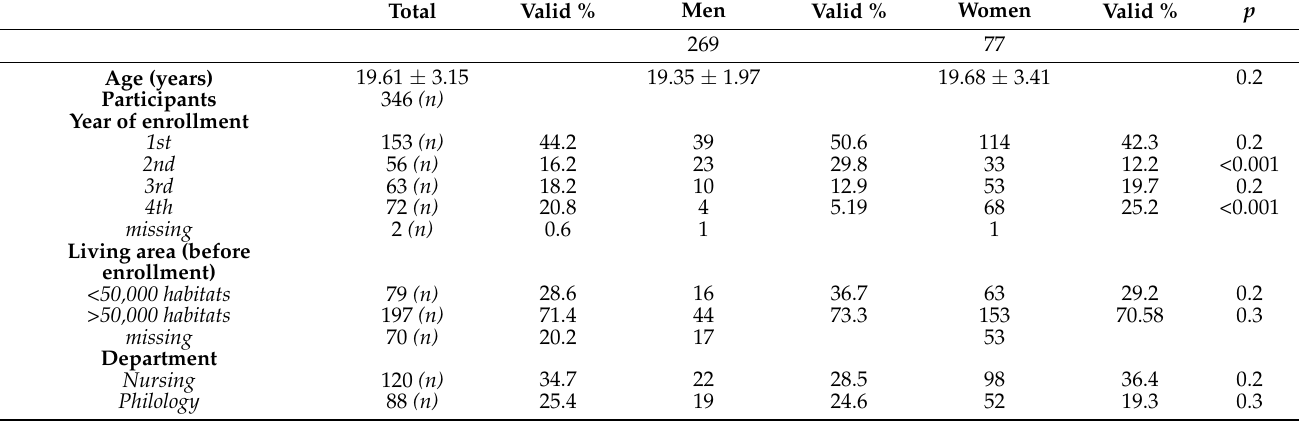
Table 1. Descriptive characteristics of